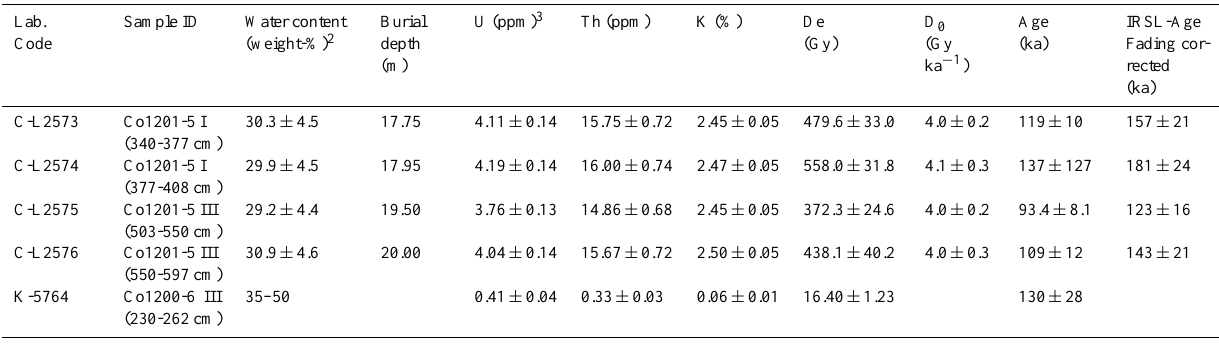
Table 2. Dating results and radioactivity data. Ages from core Co1201 were derived by IRSL dating, sample K-5764 from core Co1200 was ESR 1 dated. Lab.